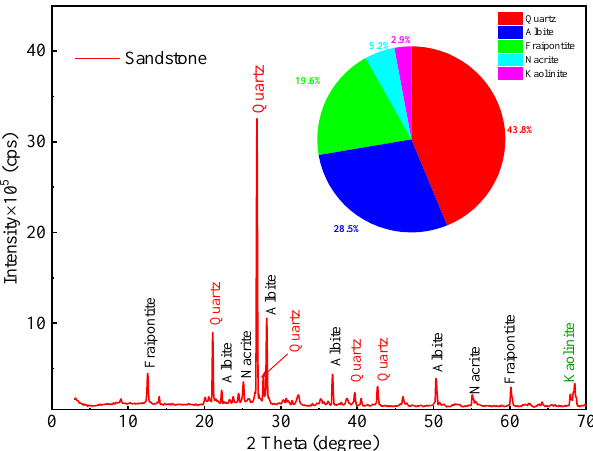
Figure 1. Location of the Xinjiang province from where the sandstone samples were obtained: ( a ) Location in China; ( b ) Detailed map of Xinjiang Province, China; ( c ) Actual view; ( d ) Satellite map of sampling point; ( e ) Samples. Red circle: rough location of the tested sandstone.